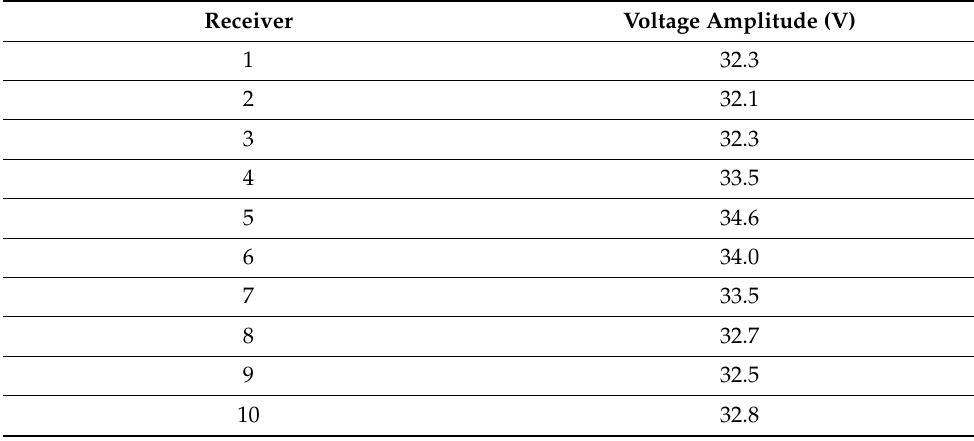
Table 2. Voltage amplitude measurements of the 1 ⁄ 4 wavelength